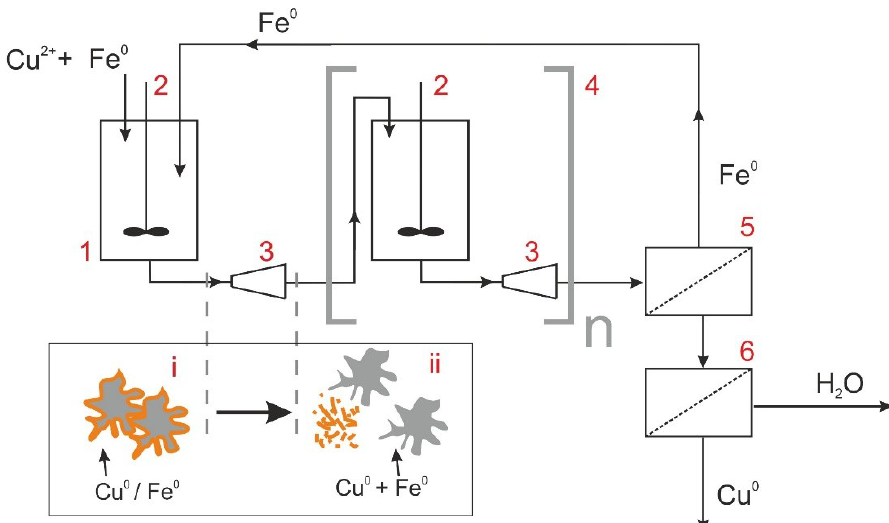
Figure 7. Principal scheme for commercial implementation for Cu extraction from mining waste water: 1—container for suspension; 2—paddle mixer; 3—mixer-disperser; 4—a set of tanks, mixers, and HSMD; 5—magnetic separator; 6—mechanical filter; i—Cu cemented on Fe particles before the cavitation; ii— cemented Cu and Fe particles after the cavitation; Arrows indicating flow directions.